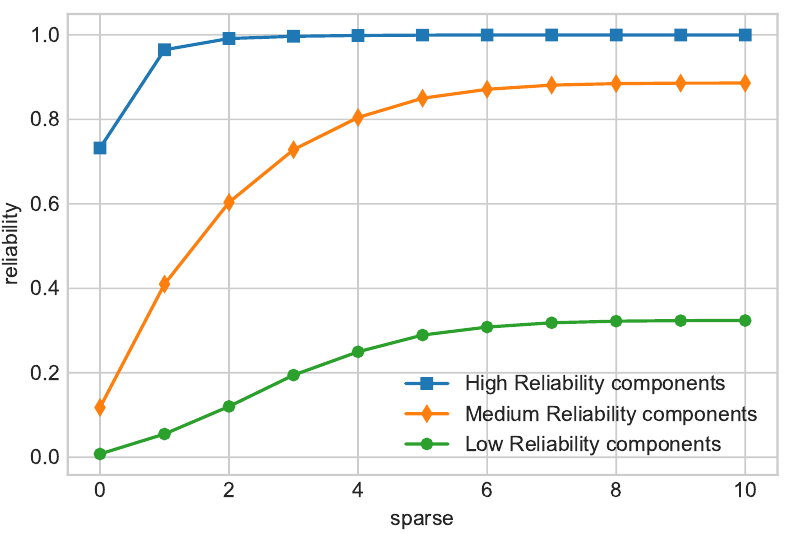
Figure 2. System reliability for consecutive 5-out-of-15 systems with sparse d = { 0, . . . ,10 } . Low, medium and high reliability